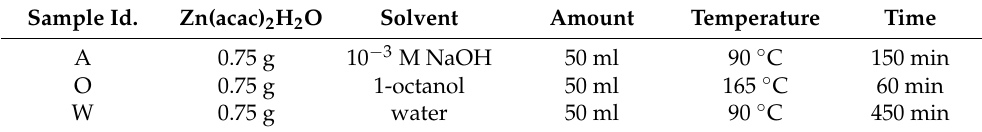
Table 1. Compilation of the sample preparations and sample identification discussed in this work. Sample